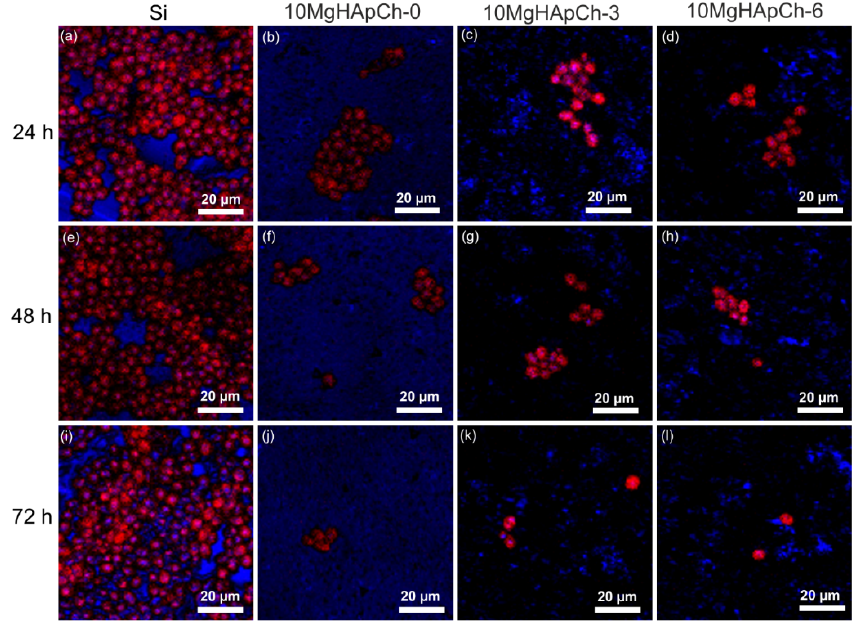
Figure 16. 2D CLSM images of Candida albicans ATCC 10231 cell development on Si discs ( a , e , i ), 10 MgHApCh-0 ( b , f , j ), 10 MgHApCh-3 ( c , g , k ), and 10 MgHApCh-6 ( d , h , l ) coatings after 24, 48, and 72 h of incubation.